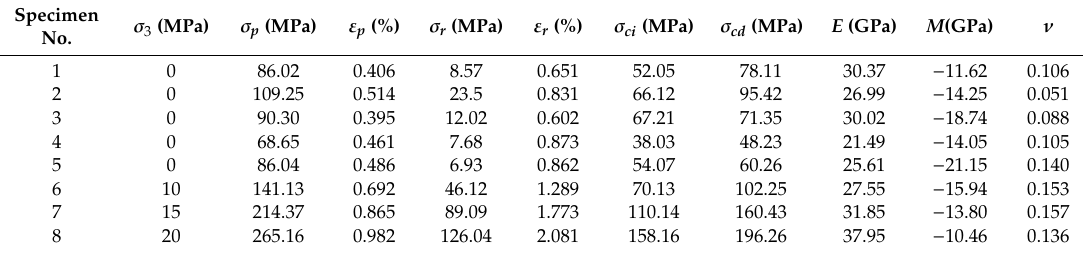
Table 2. Mechanical parameters of glutenite